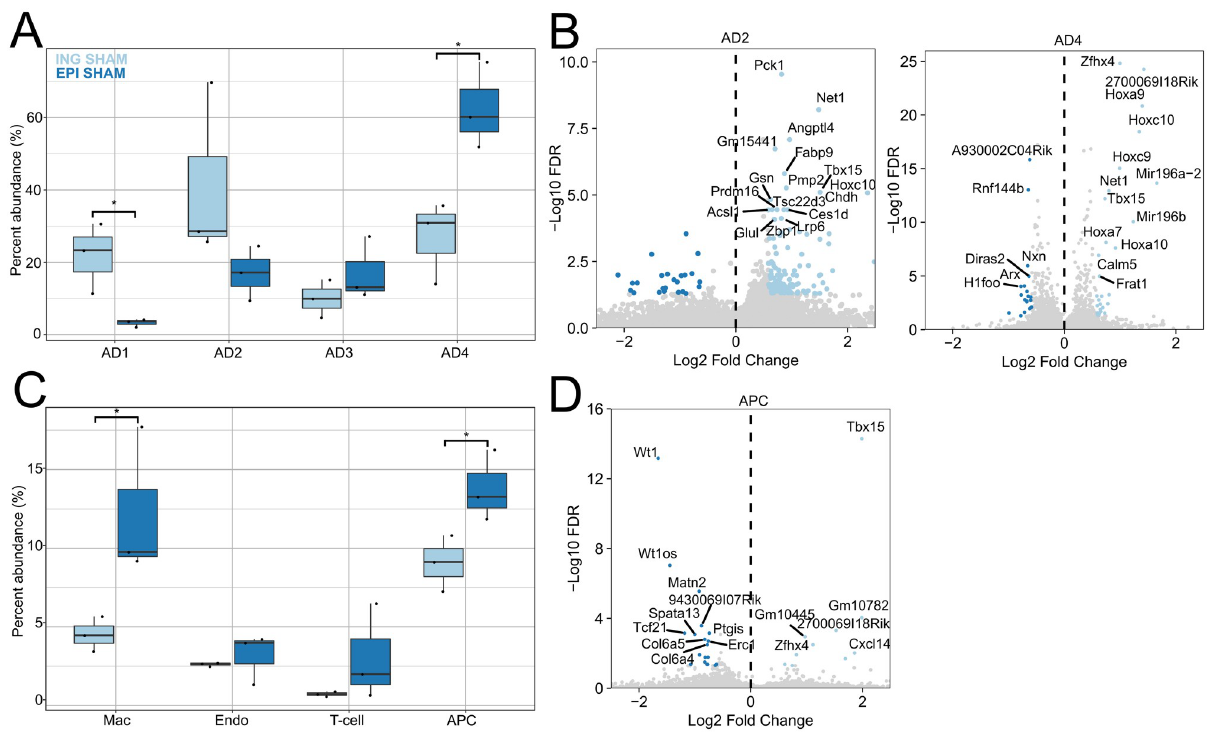
Fig 2. Adipose depot specific differences in cells from SHAM surgery mice. A. Adipocyte abundances in ING (light blue) and EPI (dark blue) depots of SHAM animals. Dots represent each biological replicate. ( n = 3). B. Gene accessibility differences for AD2 (left) and AD4 (right) clusters comparing ING and EPI cells. Positive and negative log2-fold changes respectively indicate increased accessibility in ING and EPI depots. C. Abundances of endothelial, APC, T-cells and macrophages in ING (light blue) and EPI (dark blue) depots of SHAM animals ( n = 3). D. Gene accessibility differences for APCs ING and EPI depots. Positive and negative log2-fold changes respectively indicate increased accessibility in ING and EPI depots. � p < 0.05. Two-tailed students t-test was performed for A and C.